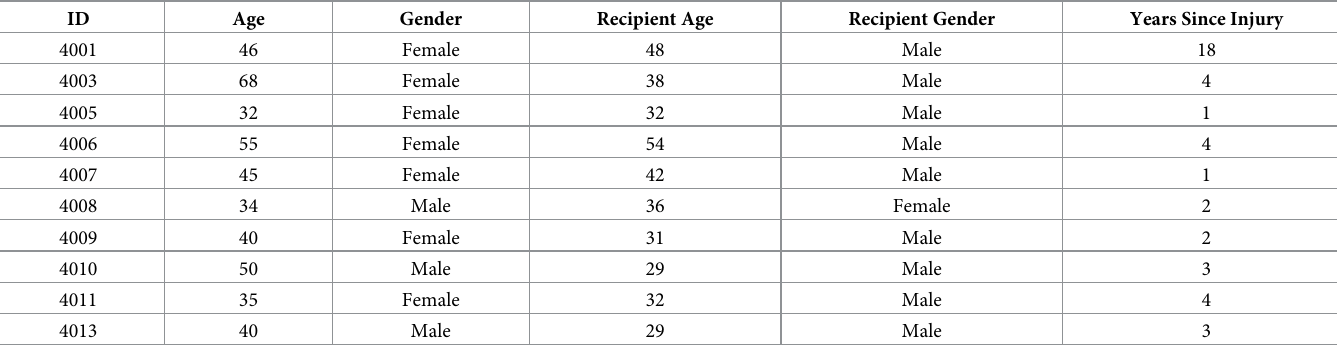
Table 3. Caregiver demographic